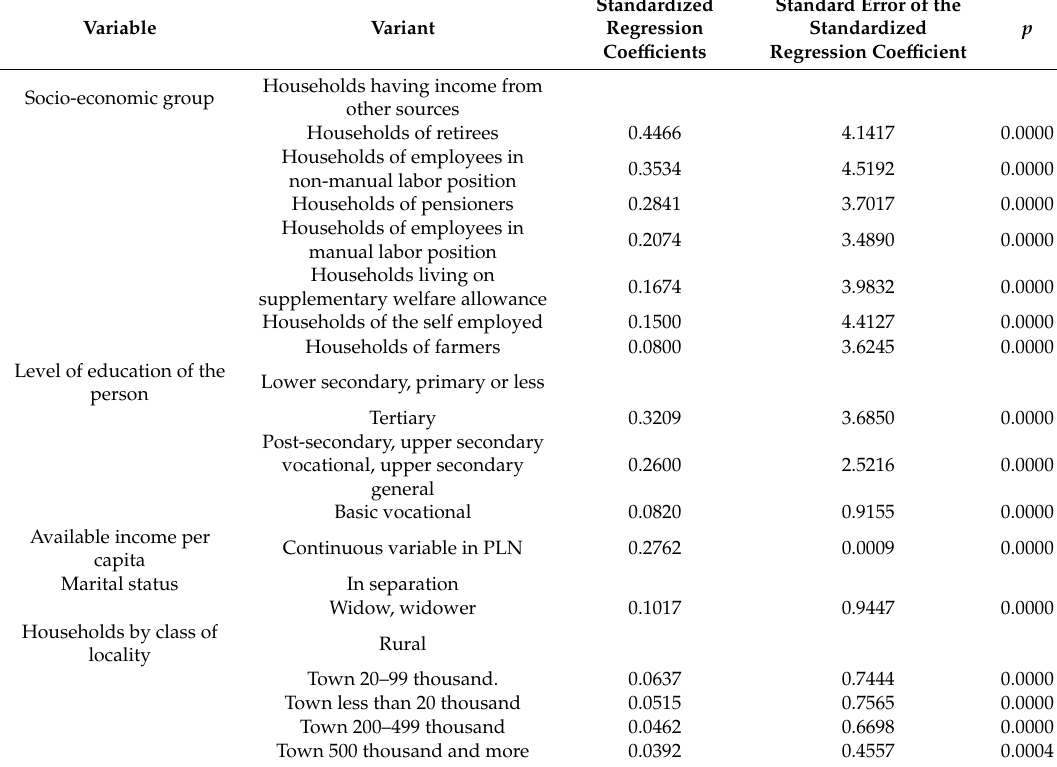
Table 4. The impact of economic and socio-demographic variables of people running one-person households on the aggregate